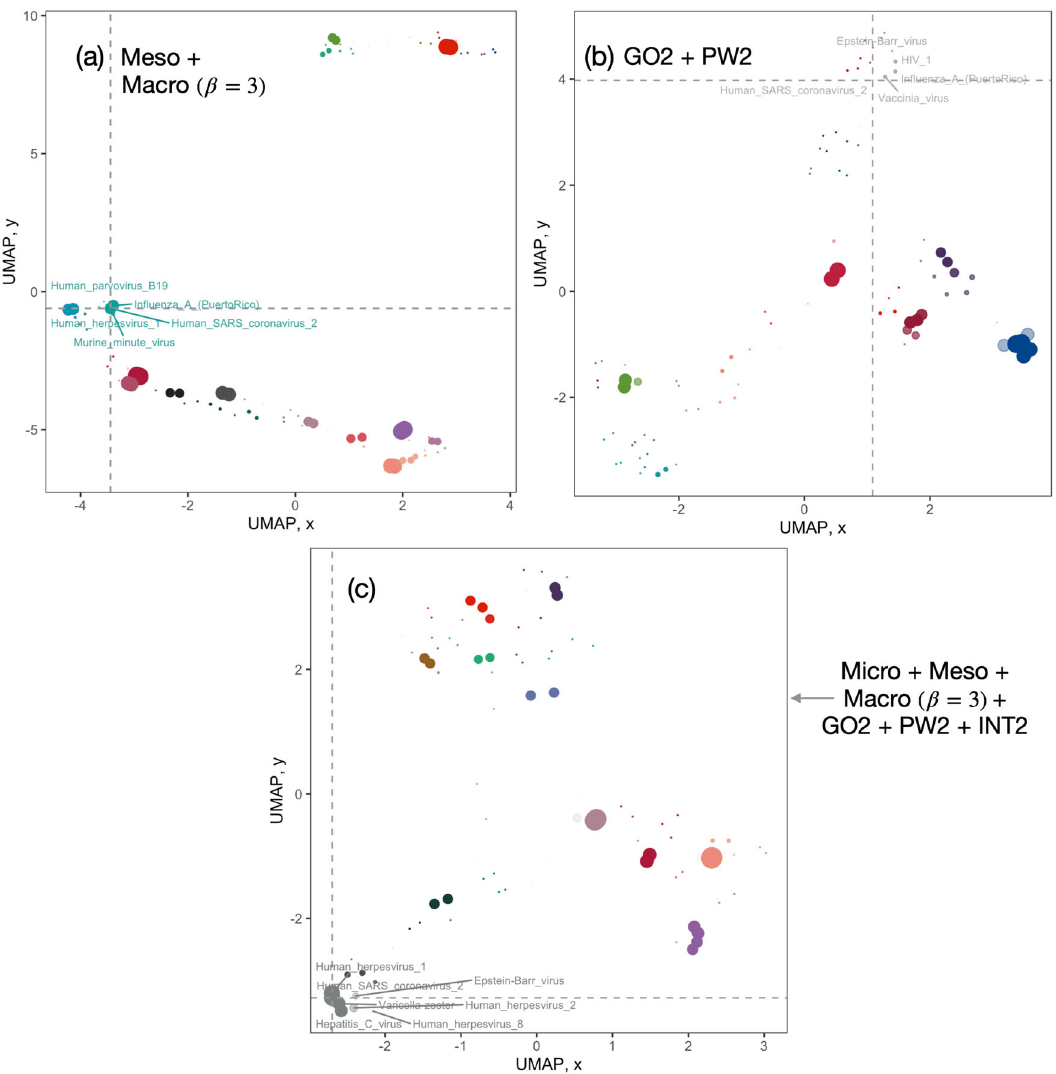
Fig. 7 Machine-learning clusters of viruses according to their statistical physics and biology. Clustering of viruses according to combination of the features obtained from the mesoscale (including modularity and depth of hierarchy), macroscale (including Massieu and Von Neumann values calculated at temporal scale β = 3), and microscale analyses (including cumulative perturbation, see Supplementary Note 6) and biological analyses (including Gene Ontology GO2, Pathways enrichment PW2, and protein interactors INT2 for fi rst- and second-order shared interactors). To map the multidimensional feature space into a 2d space, we use the UMAP dimensionality reduction technique and fi nd the clusters by means of the HDBSCAN algorithm. In all panels, viruses are shown as dots where their colors indicates their membership in clusters and their size is proportional to the reliability of their assignment to that cluster. In each panel, the labels are added to the viruses that cluster with SARS-CoV-2 and located at the intersection of the dashed lines. a Features from mesoscale organization coupled with spectral entropy and Massieu function perturbations. b Embedding using gene ontology and pathways enrichment analyses. c Features from micro-, meso-, and macroscale analyses are combined with biological analyses GO2, PW2, and